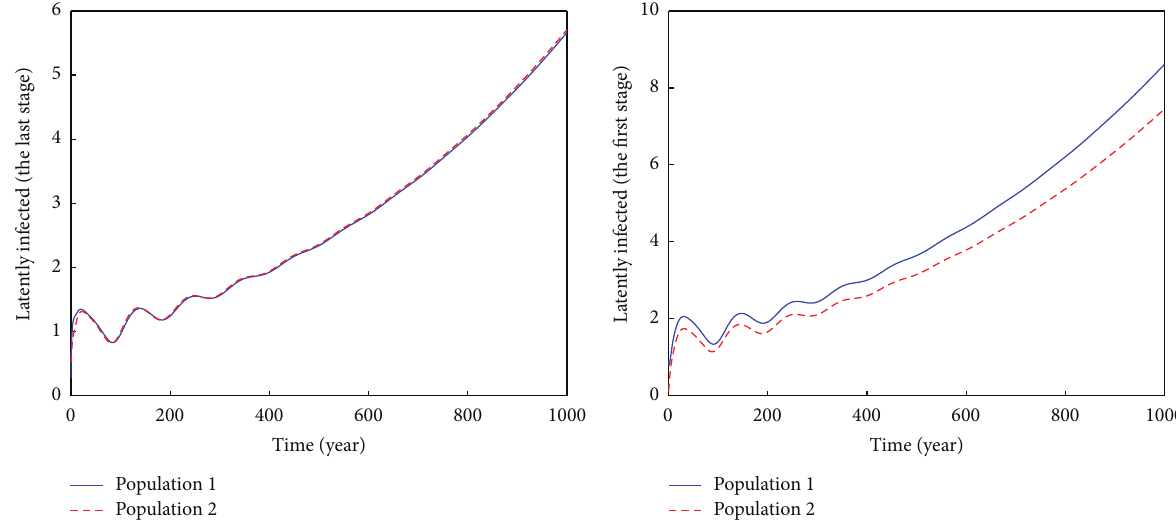
> 1 . All other parameters are as in 0